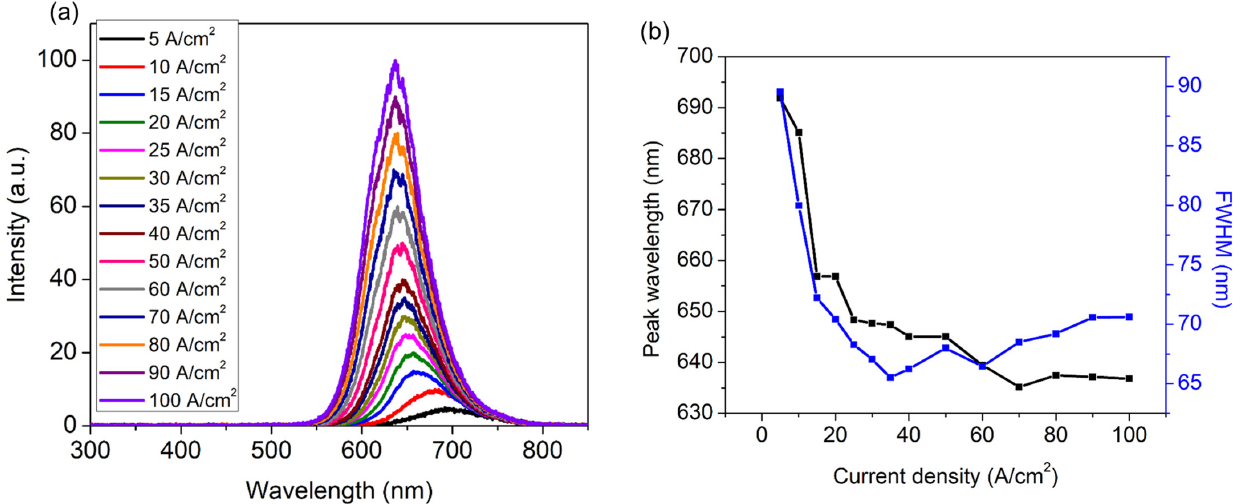
Figure 2. ( a ) Emission spectra from 5 to 100 A/cm 2 from a 100 × 100 µm 2 device and ( b ) the peak wavelength and FWHM with current densities from the 100 × 100 µm 2 device. wavelength and FWHM with current densities from the 100 × 100 µ m 2